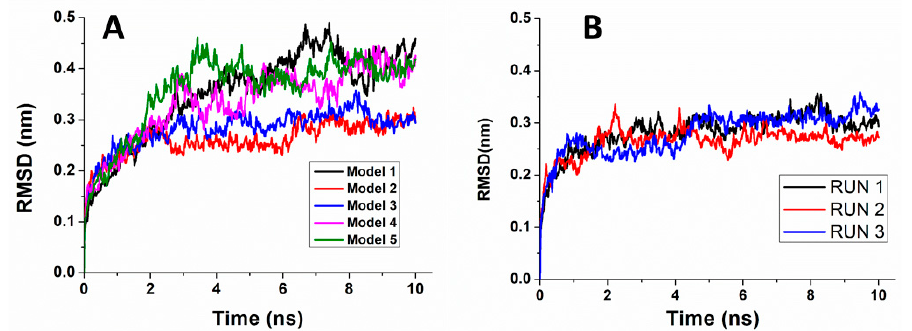
Figure 6. Temporal evolution of the all atom Root Mean Square Displacement (RMSD) for: ( A ) a representative run for each of the five DBD-miR4749 models and ( B ) the three replicate runs of Model 3.